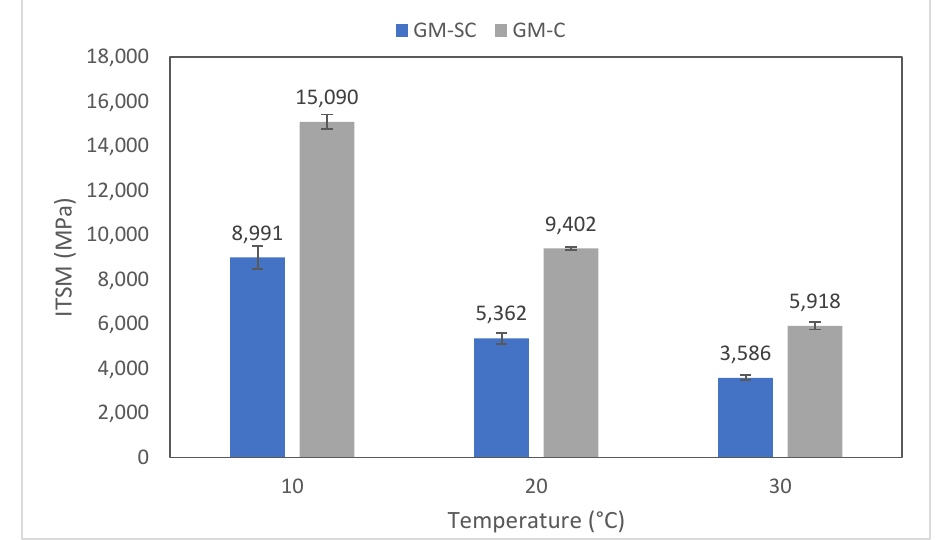
Figure 8. Average ITSM values for grouted macadam samples.